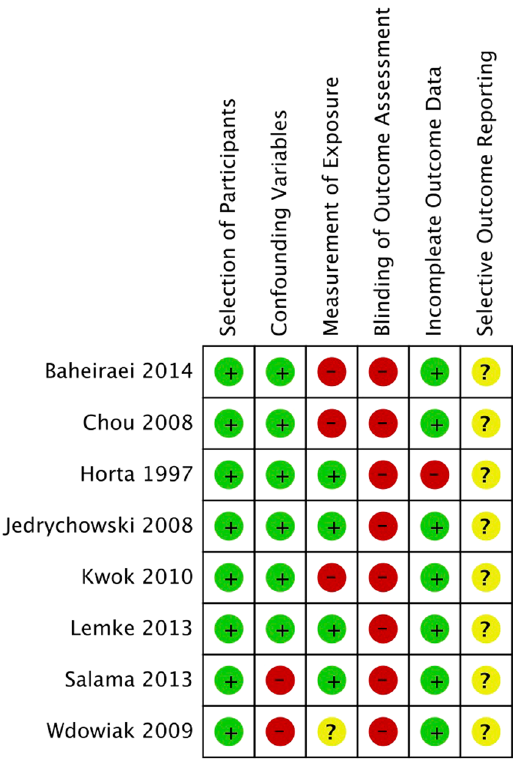
Figure 3. Risk of bias summary review authors’ judgements about each risk of bias item for each included